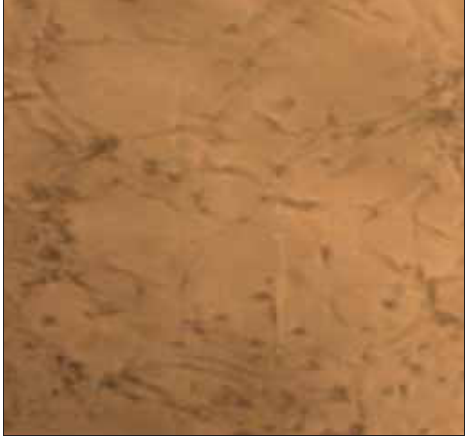
Figure-8: Cytopathic effect produced by field strain of fowl pox virus after 96 h of PI (×10)